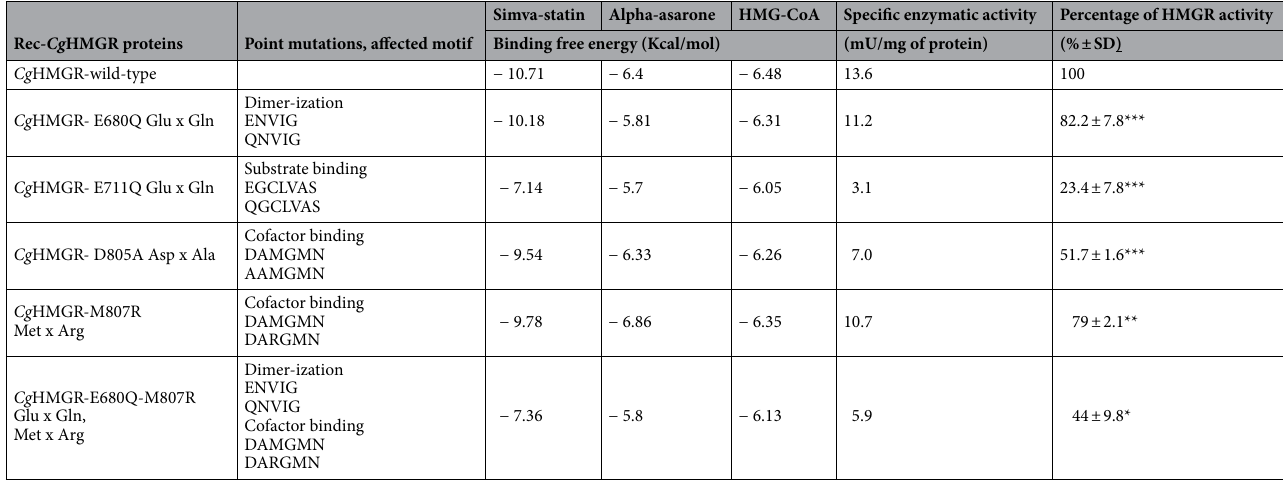
Table 2. The enzymatic activity and binding energies of the point mutations made in the motifs of the dimerization site, substrate binding site, and cofactor binding site of Cg HMGR. Point mutations were made in the catalytic domain of Cg HMGR to express various recombinant proteins (Rec- Cg HMGR) (as described in Material and Methods). The aa of the wild-type sequence is shown in green and that of the mutated protein in red. The site of the motif sequence is indicated. The binding energies of Cg HMGR (wild-type and mutated) with its HMG-CoA substrate and probable inhibitors (simvastatin and alpha-asarone) were estimated by docking. The enzymatic activity of the recombinant enzymes is calculated as a percentage of the activity of the wild-type enzyme (considered as 100%). Data are expressed as the average of three independent replicates ± standard deviation (SD). *** P < 0.0005 ** P < 0.0052, * P < 0.0153. Significant differences compared to the wild-type protein based on a paired Student’s t -type